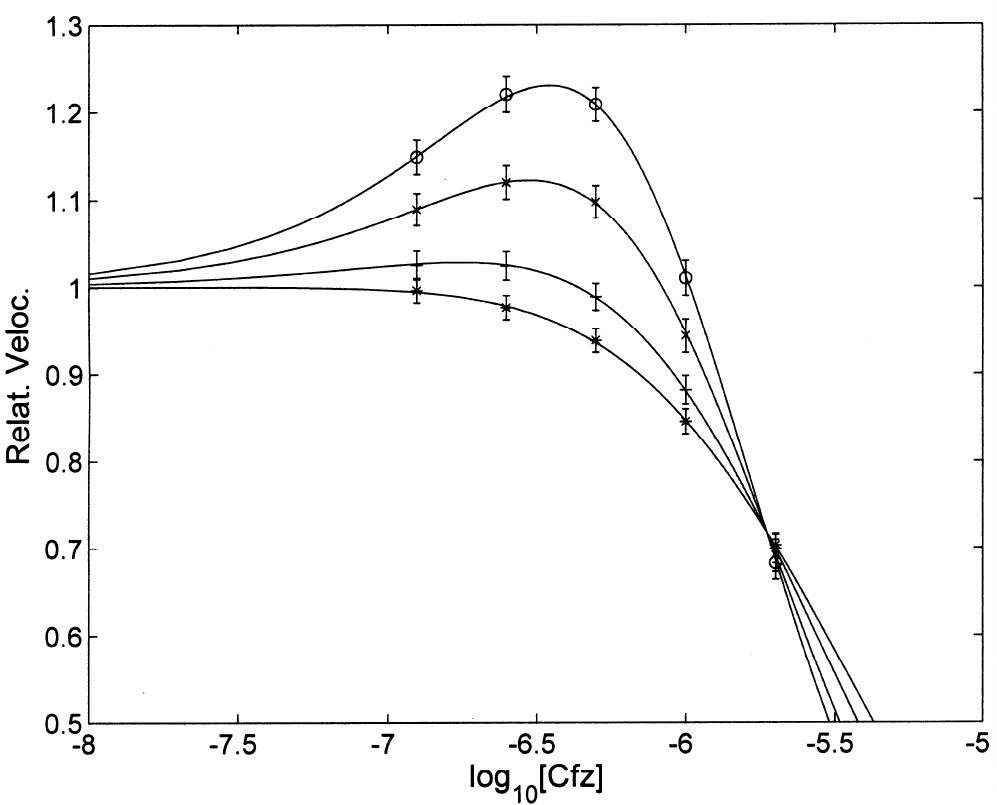
Figure 3. Dependence of relative velocity of IDE enzymatic activity on [CFZ] at different fluorogenic substrate concentrations, namely 5 µM (o), 10 µM (x), 20 µM (+) and 30 µM (*). Continuous lines correspond to Equation (2) for various substrate concentrations.